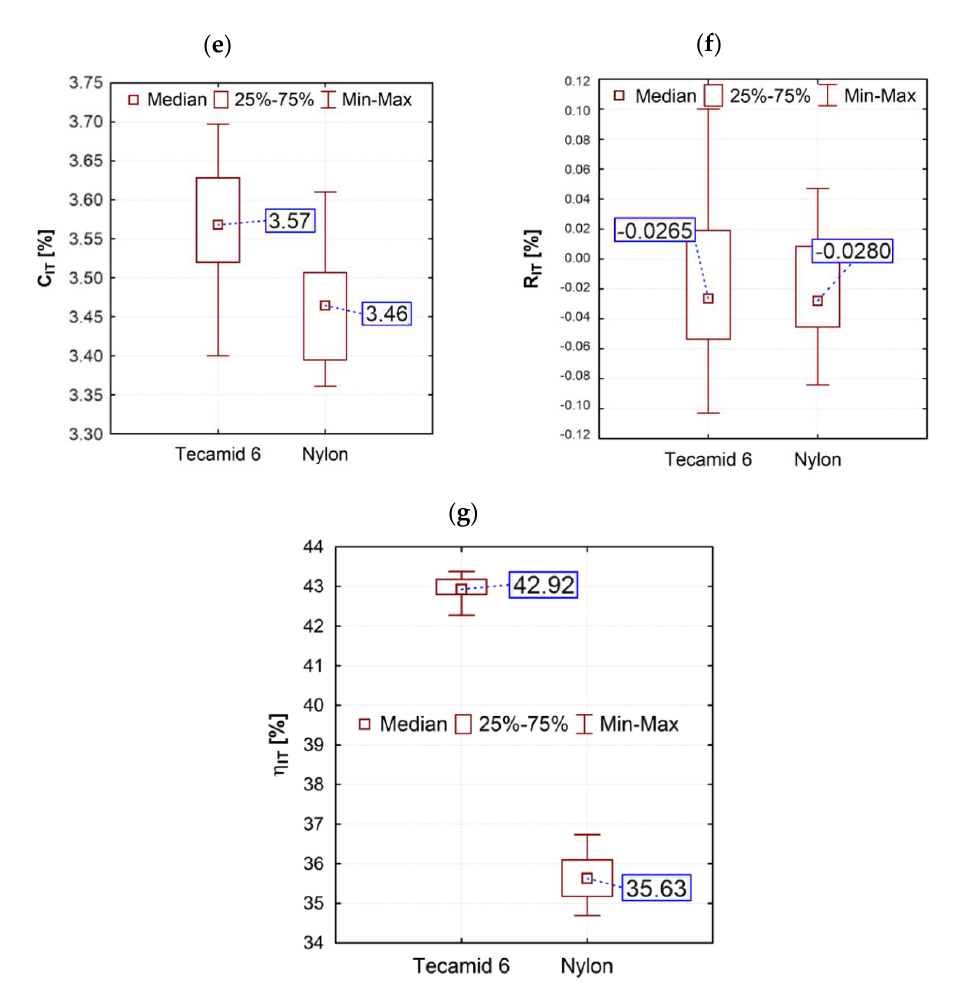
Figure 8. Box plots of the parameters obtained in the indentation test: ( a ) Vickers indentation hardness; ( b ) Martens hardness; ( c ) indentation modulus; ( d ) indentation stiffness; ( e ) indentation creep; ( f ) indentation relaxation; ( g ) indentation ratio of the work of force on elastic to total deformation.